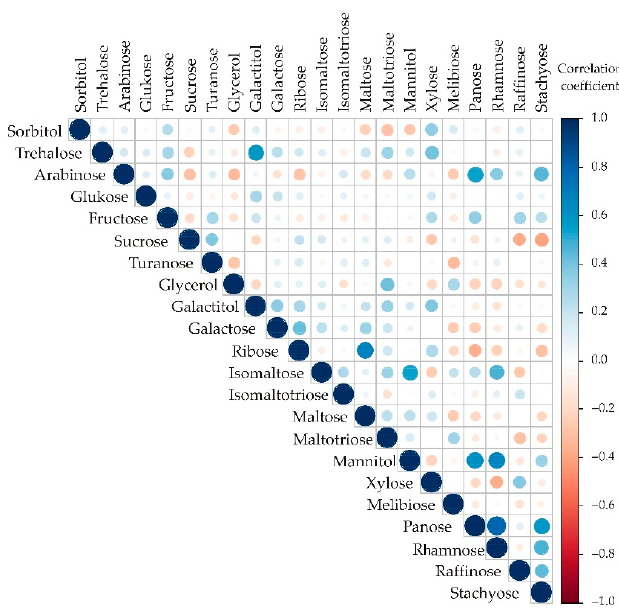
Figure A2. Color correlation graph between sugar content in plum samples.